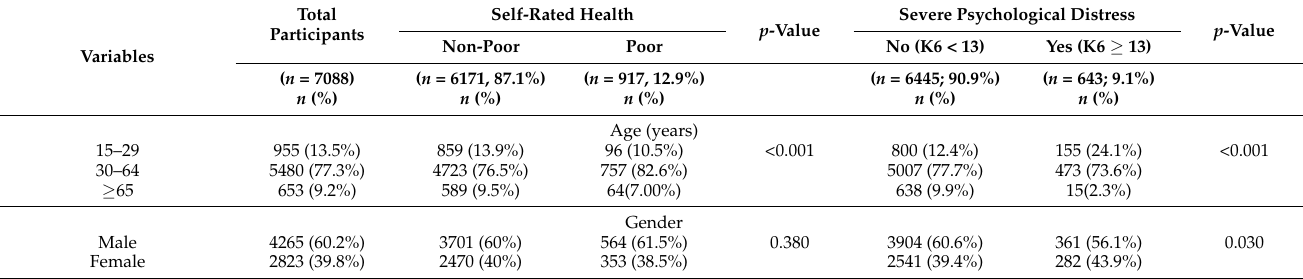
Table 1. Self-rated health and psychological distress by demographic characteristics of participants ( n = 7088).